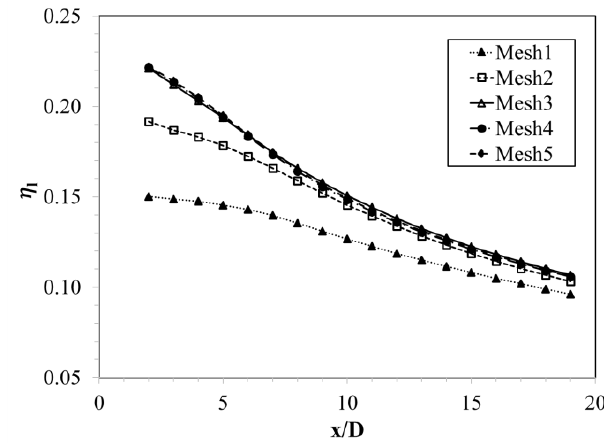
Figure 6. Influence of grid mesh on the results.